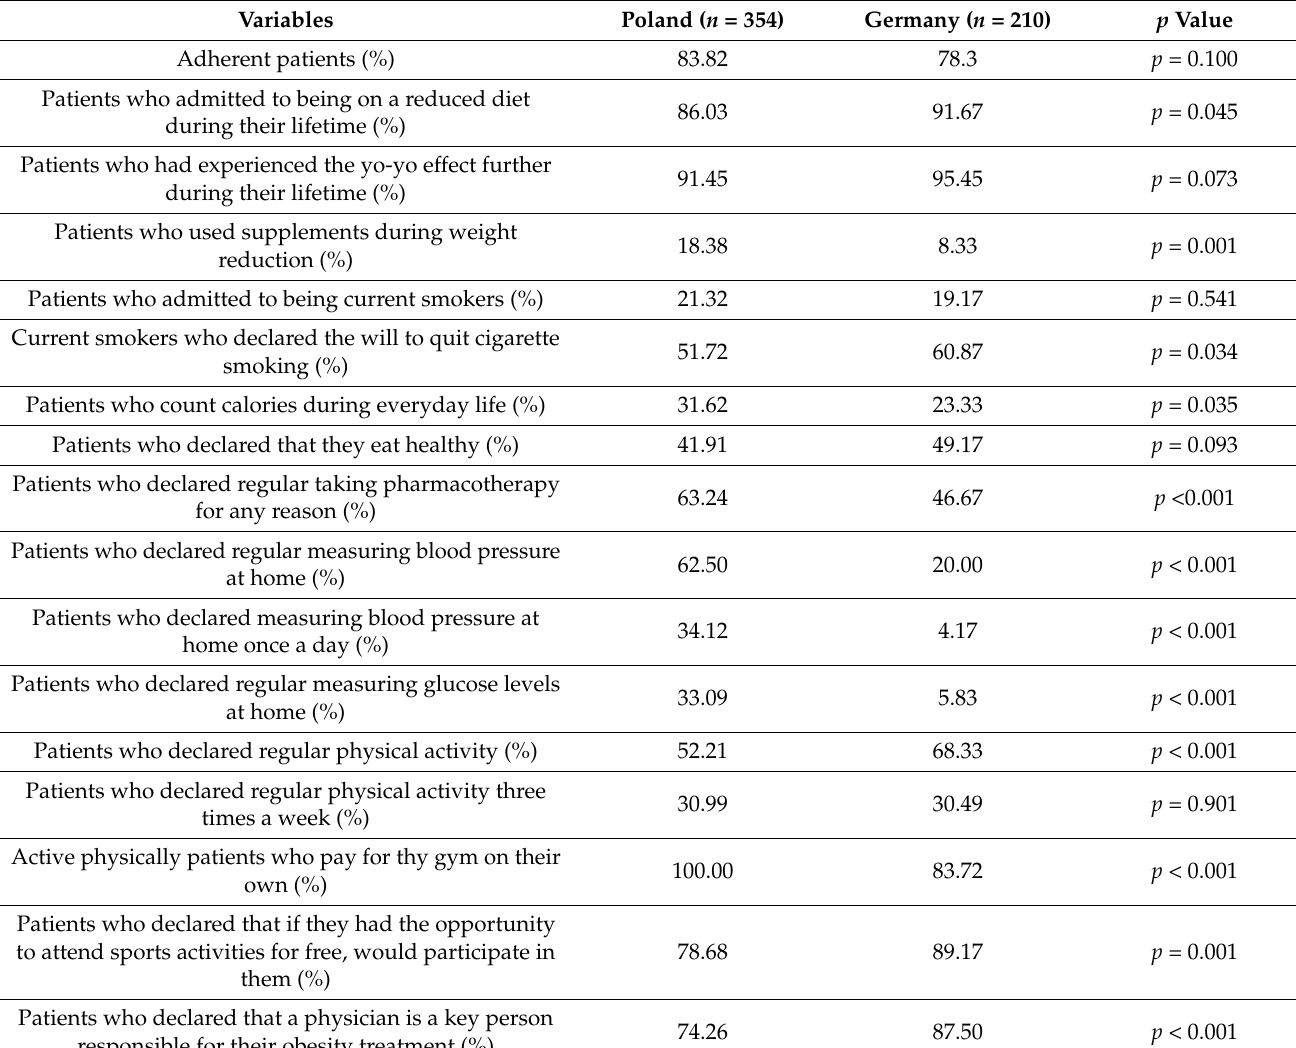
Table 2. Comparison of adherence between patients treated for morbid obesity living in Poland ( n = 354) and Germany ( n =